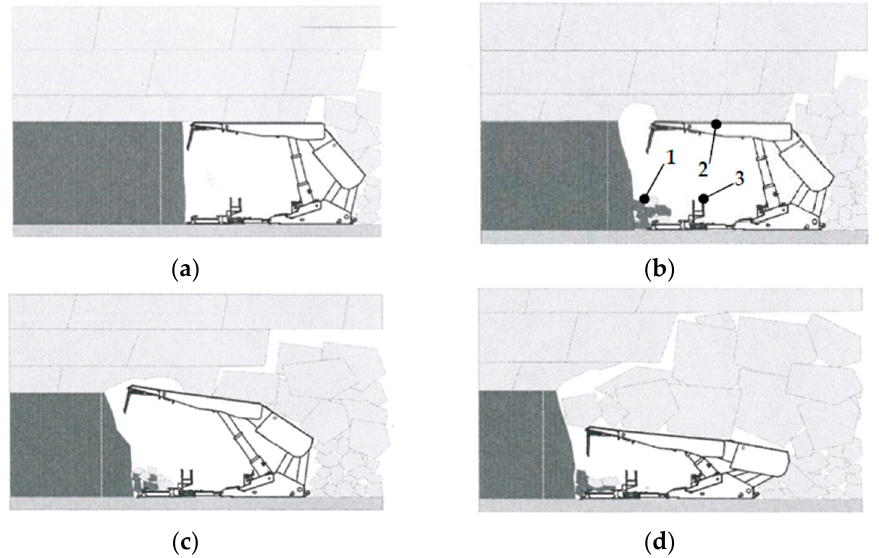
Figure 1. Roof fall progress in the working of a longwall: ( a )—stable condition, ( b )—unstable condition resulting in minor roof fall, ( c )—unstable condition resulting in medium roof fall, ( d )—unstable condition resulting in major roof fall, 1—roof fall, 2—canopy, 3—armored face conveyor (AFC) (Source: Own elaboration).